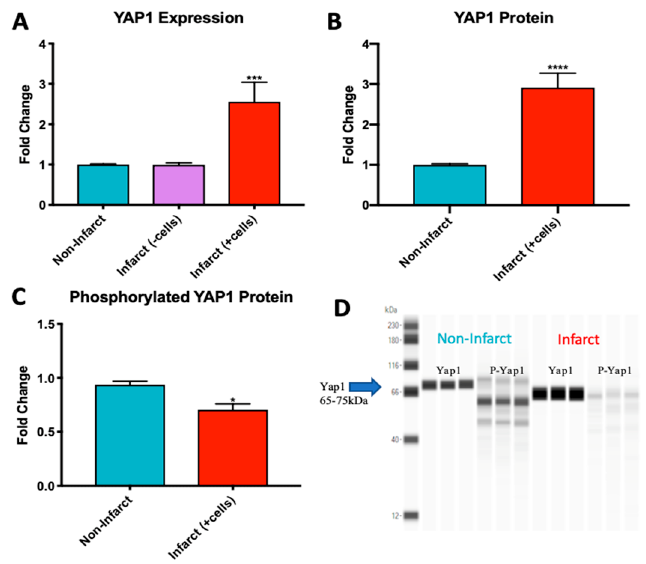
Figure 5. Infarct zones of sheep treated with cells express higher levels of active YAP1 when compared with non-infarcted regions as shown by PCR ( A ). YAP1 protein concentration was elevated compared to non-infarcted regions, confirming the PCR results ( B ). The ratio of phosphorylated YAP1 to non-phosphorylated YAP1 declined in the infarcted region of the heart compared to the non-infarcted region ( C ). Western blot image shows change in concentration of phosphorylated and non-phosphorylated YAP1 ( D ). n = 3, * p < 0.05, *** p < 0.001, **** p < 0.0001. Fold changes are shown as the mean ± SEM. All samples were run in triplicate.